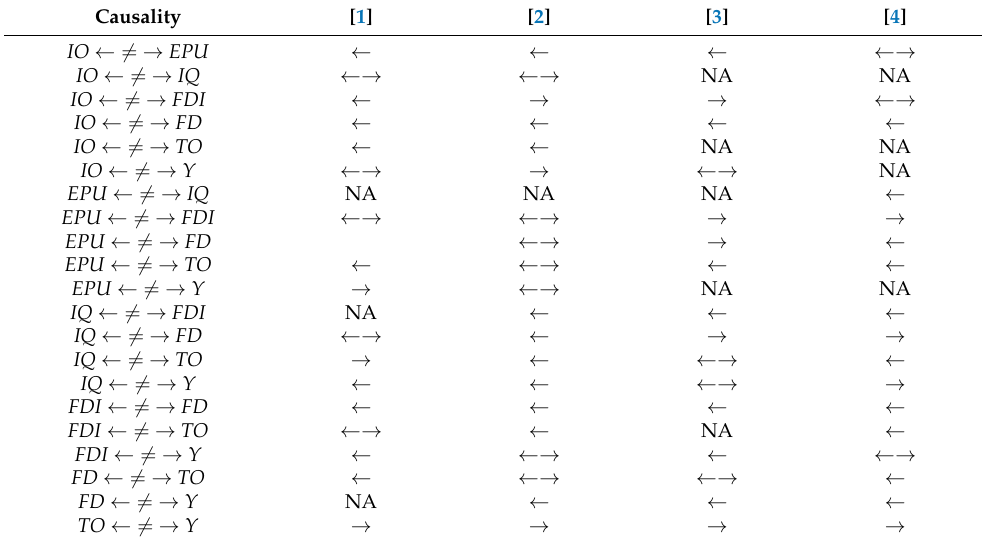
Table 14. Summary of Granger causality